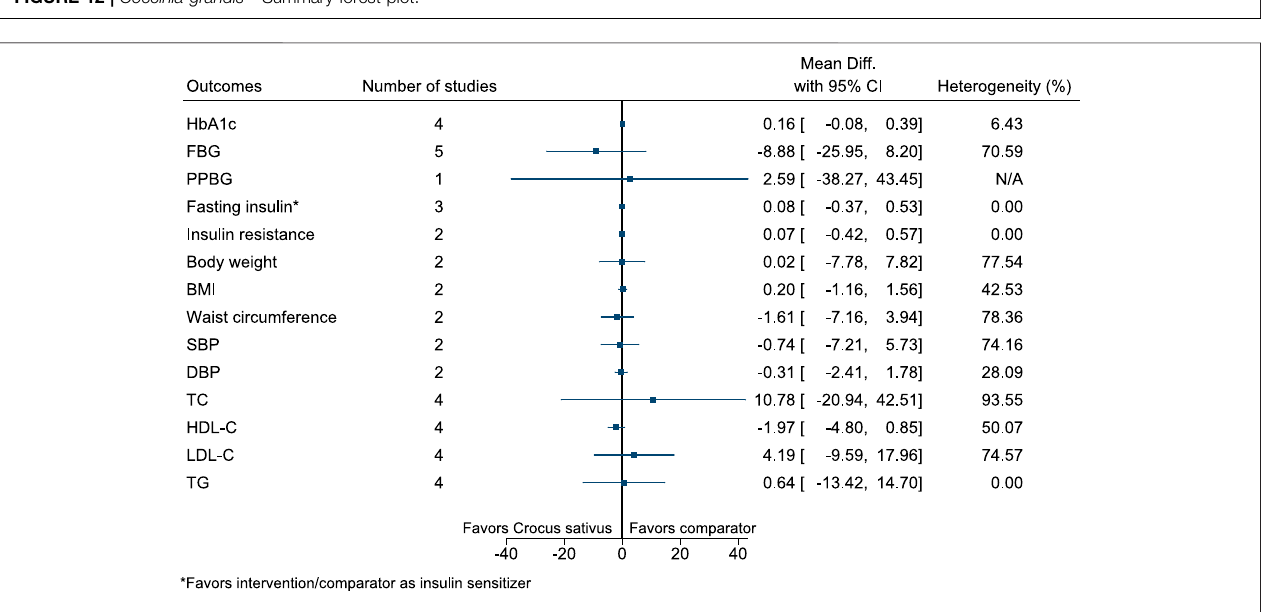
FIGURE 12 | Coccinia grandis — Summary forest plot.